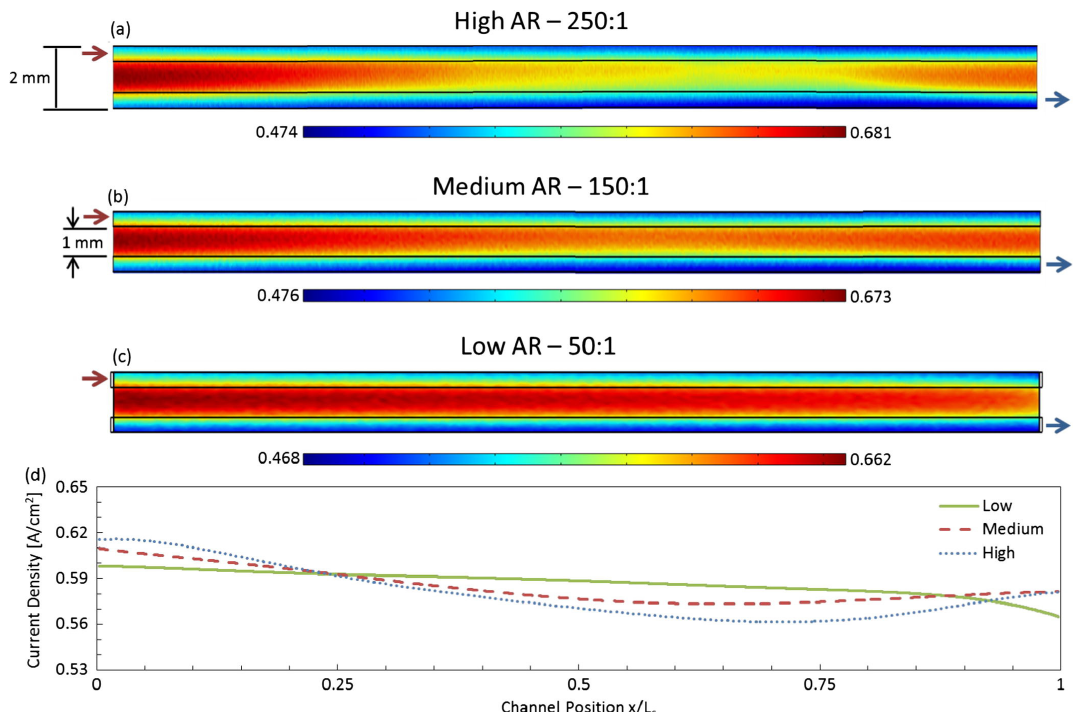
Figure 8. The current density distribution of PEMFC with a ( a ) high length to width ratio, a ( b ) medium length to width ratio, a ( c ) low length to width ratio, and ( d ) the current density at x / L c positions